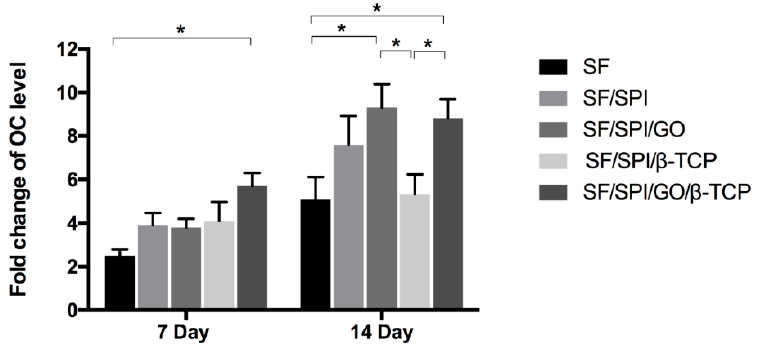
Figure 14. OC mRNA expression of BMSCs on the SF/SPI-based composite scaffolds on day 7 and 14. Statistical significance relative to each group: * p < 0.05.